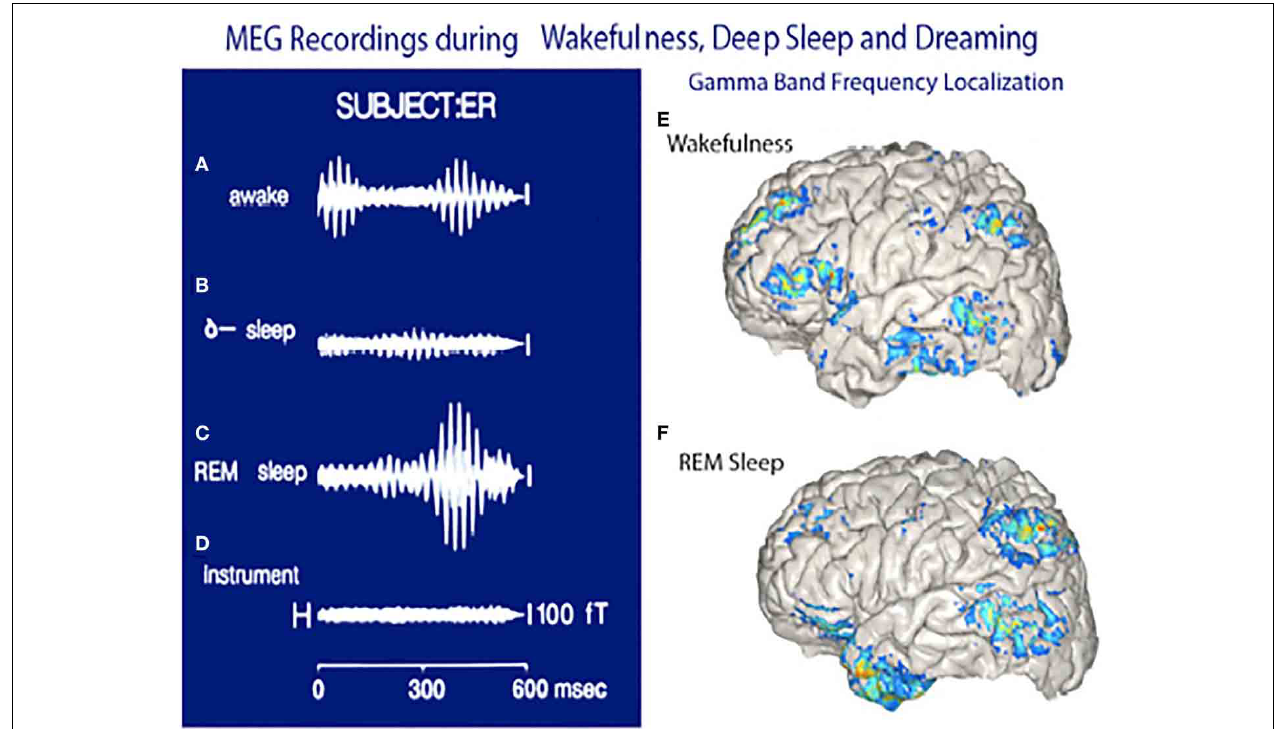
FIGURE 15 | Magnetoencephalographic (MEG) recordings in three functional states. (A) Magnetic recording demonstrating gamma band activity following a sensory stimulus in awake subject. (B) Recordings from same subject during deep, dreamless sleep. (C) Gamma band activity while dreaming. (D) Instrument noise in the absence of a subject. (E) Localization